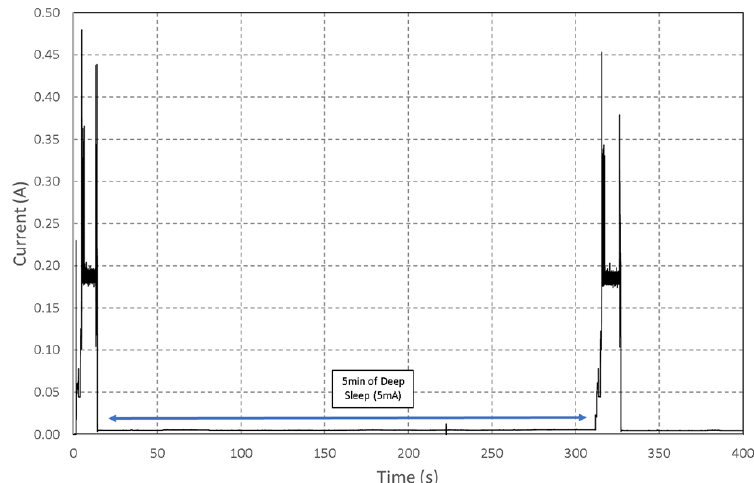
Figure 10. Measured of current consumption of the ESP32-Cam during a complete cycle with 2 photos